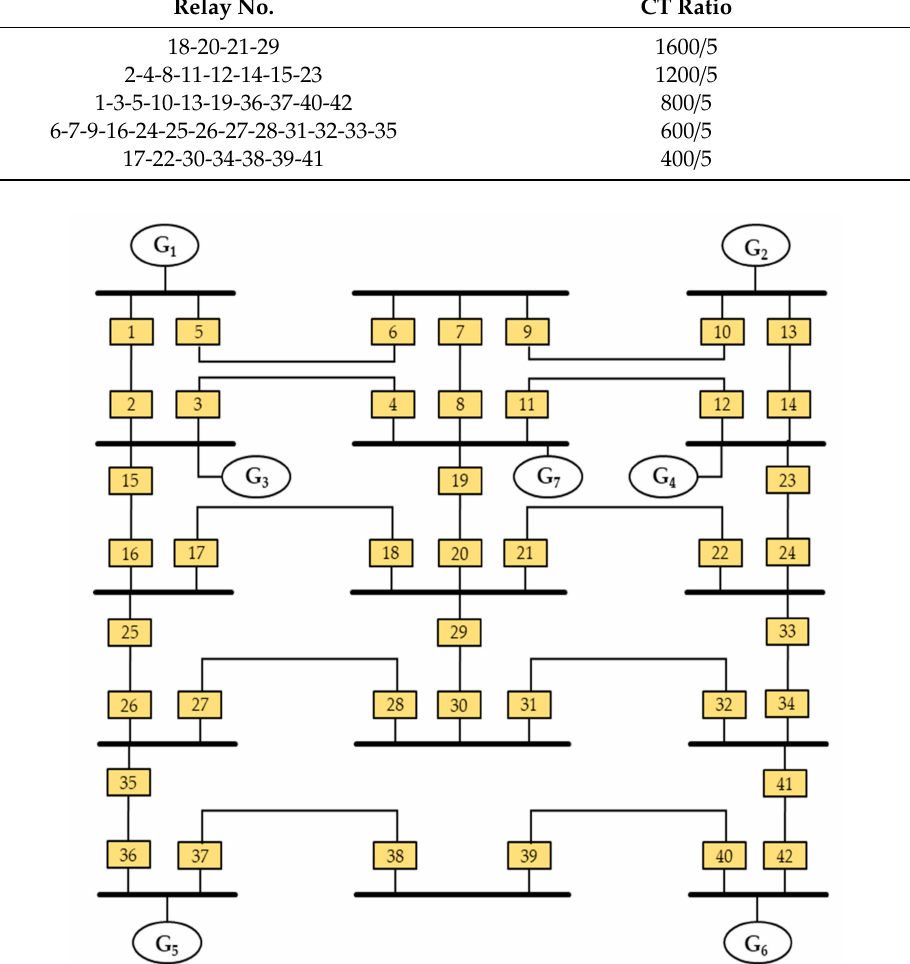
Table 12. Current transfer ratio for the relay of the IEEE 15-bus system. Relay No. CT Ratio